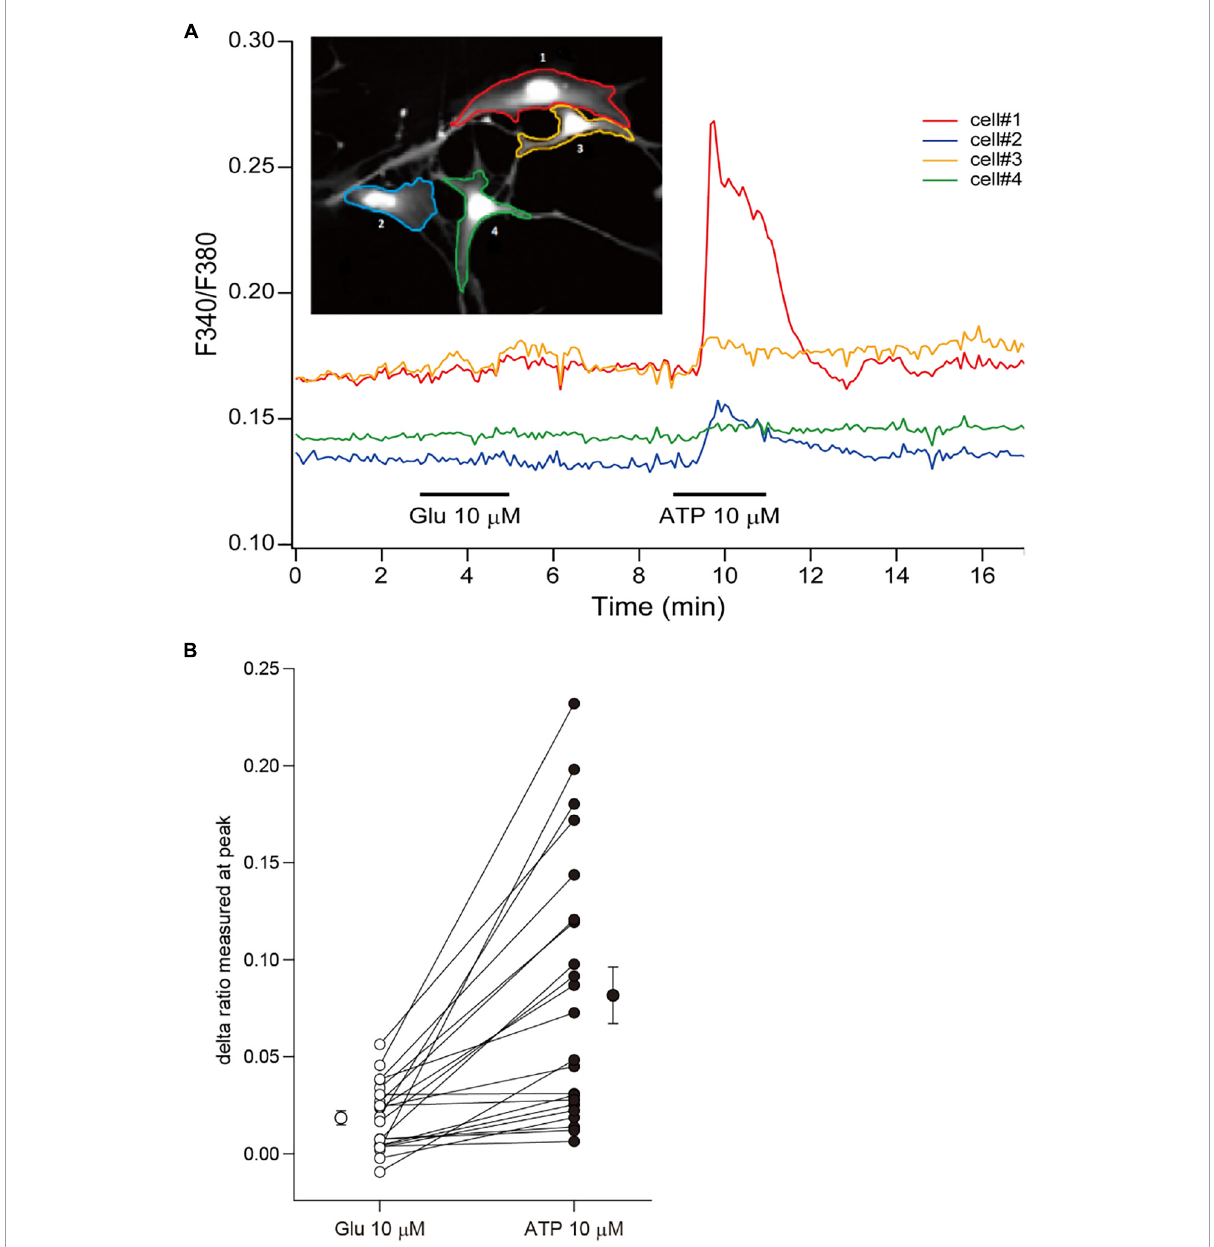
FIGURE3 Calcium responses of ferret astrocytes. (A) Effect of bath-applied glutamate (10 µ m) and ATP (10 µ m) on intracellular calcium concentration [(Ca 2 + ) i ] of ferret astrocytes. The [Ca 2 + ] i was measured from the fluorescent images of cells and expressed as the ratio of Fura-2 intensities at 340 and 380 nm (F340/F380). The time course of changes in the F340/F380 of individual cells shown in the inset are plotted by the corresponding-colored lines depicting the regions of interest. (B) Summary plots representing the changes in Fura-2 ratio following treatments of individual cells with glutamate and ATP, expressed as delta ratio (peak ratio during reagent application minus ratio prior to application). The mean values ( ± SEM, n = 22 cells from 1 independent culture) of the delta ratios induced by each reagent are plotted beside the individual